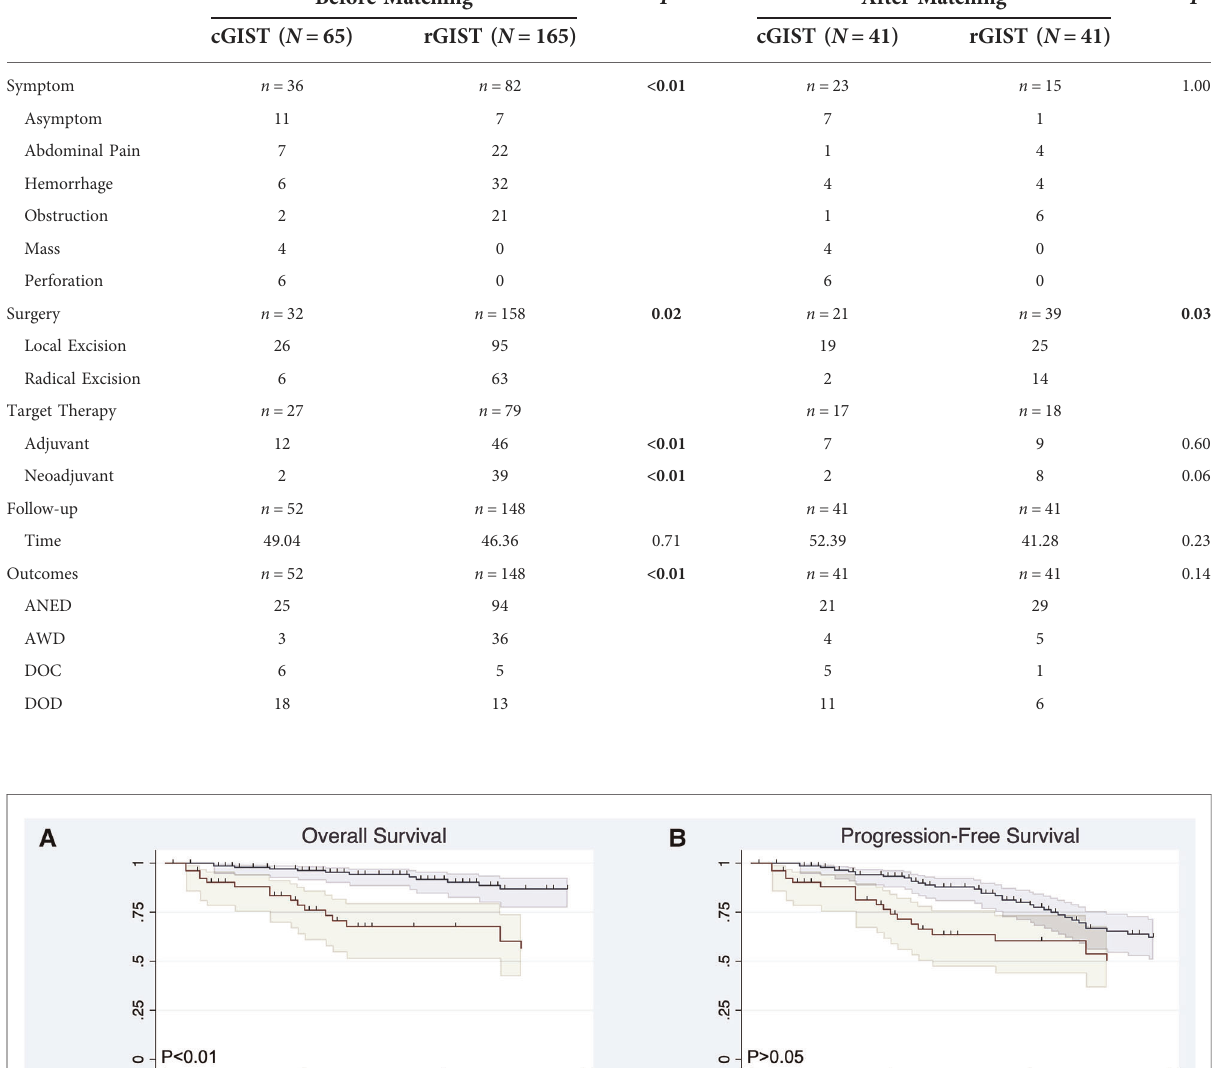
TABLE 2 Clinical characteristics and follow-up results in unmatched and matched cohorts. Before